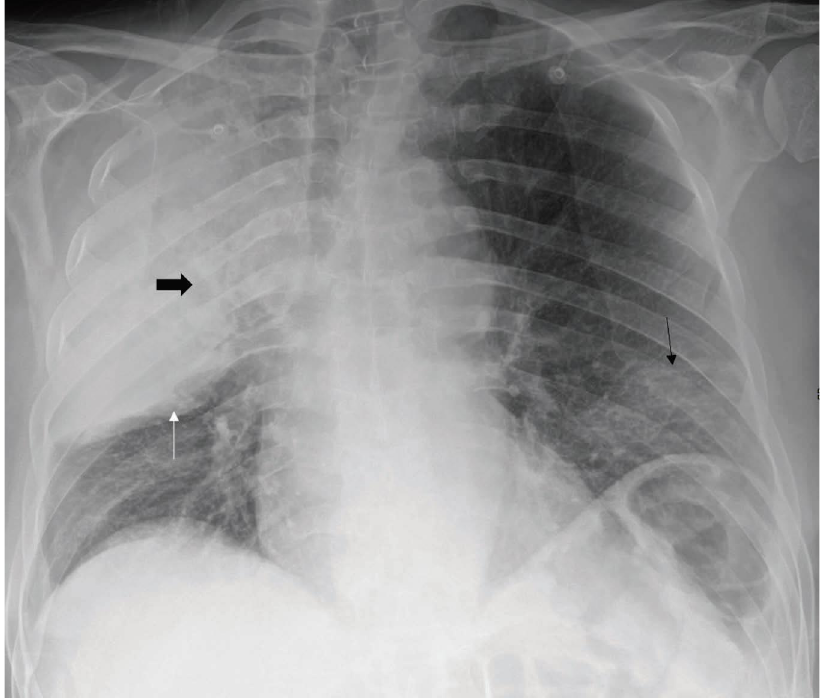
Figure 1: Chest X-ray. AP projection. Consolidation expanded the right upper lobe, with a mildly bulging horizontal fssure and a thin white arrow. Several small foci of cavitation exist within the consolidated RUL, one of which is indicated by the thick black arrow. Bilateral lower zone ground-glass opacities, thin black arrow on the